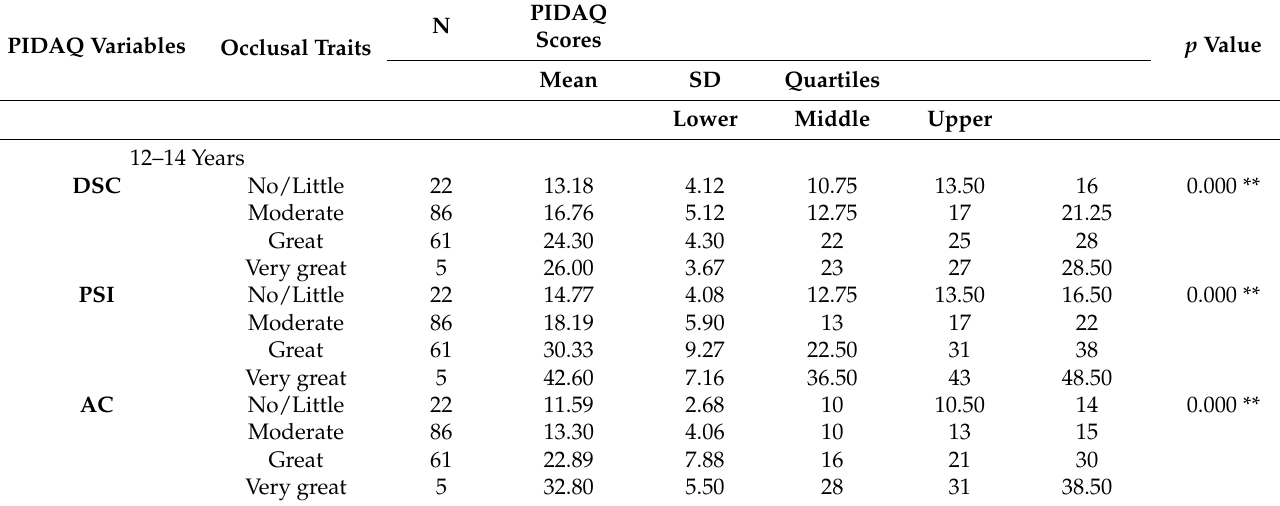
Table 10. Discriminant validity of the PIDAQ(A) with IOTN-DHC.